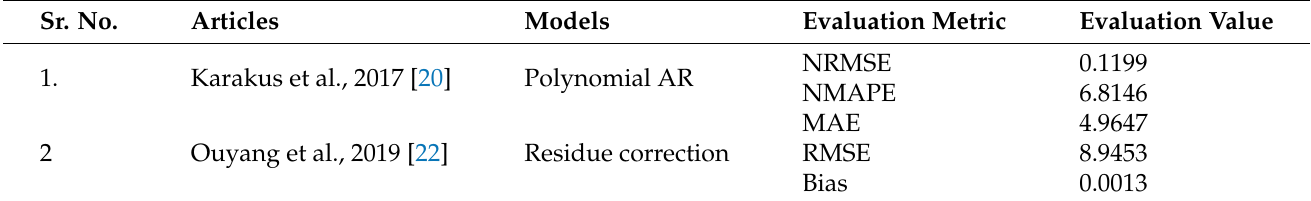
Table 2. Time series methods for long term